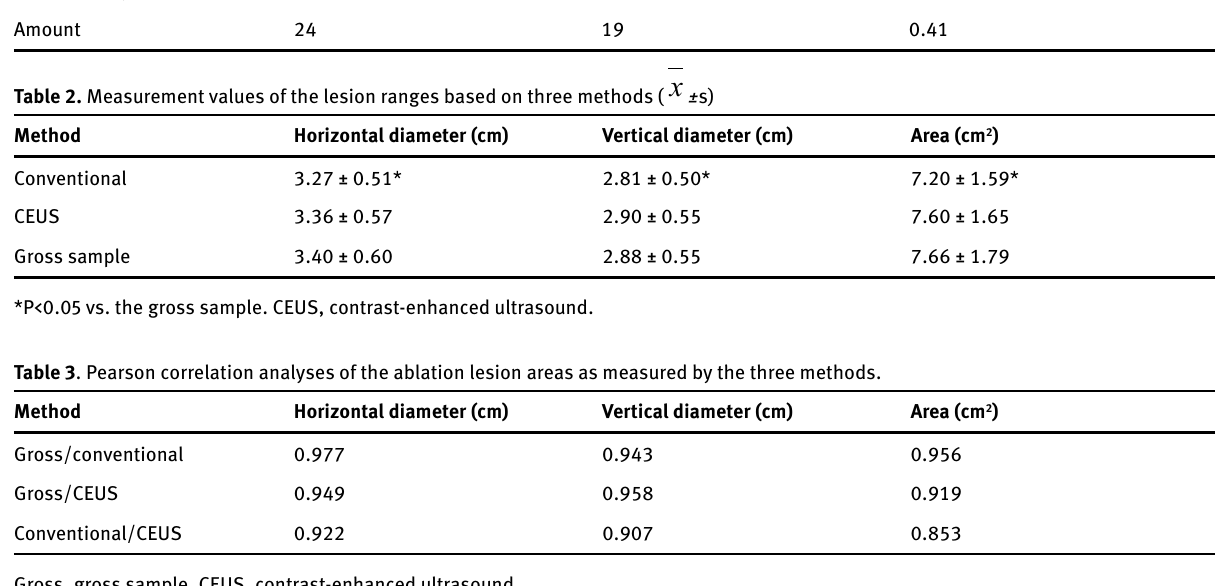
Table 2. Measurement values of the lesion ranges based on three methods (